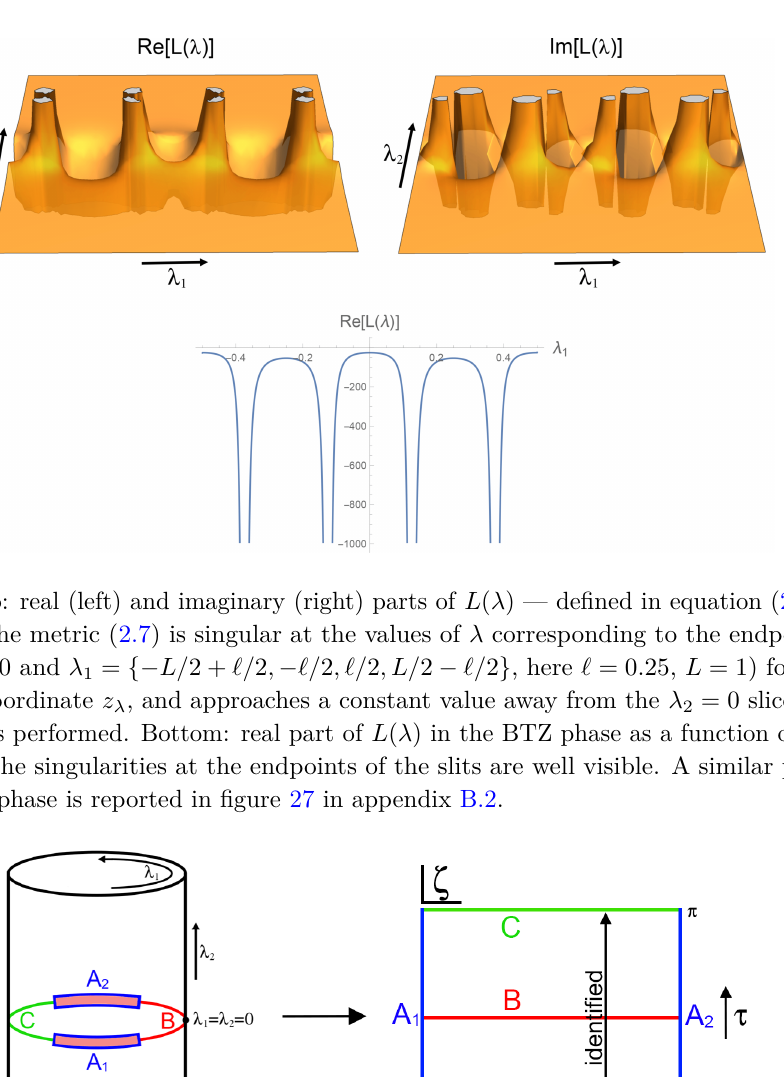
Figure 5 . We conformally map the infinite cylinder with slits in λ , cylinder in ζ , ¯ ζ coordinates. The planar representation of the finite cylinder reported here is useful to understand how the two possible dual spacetimes, depicted in figures 6 and 7,